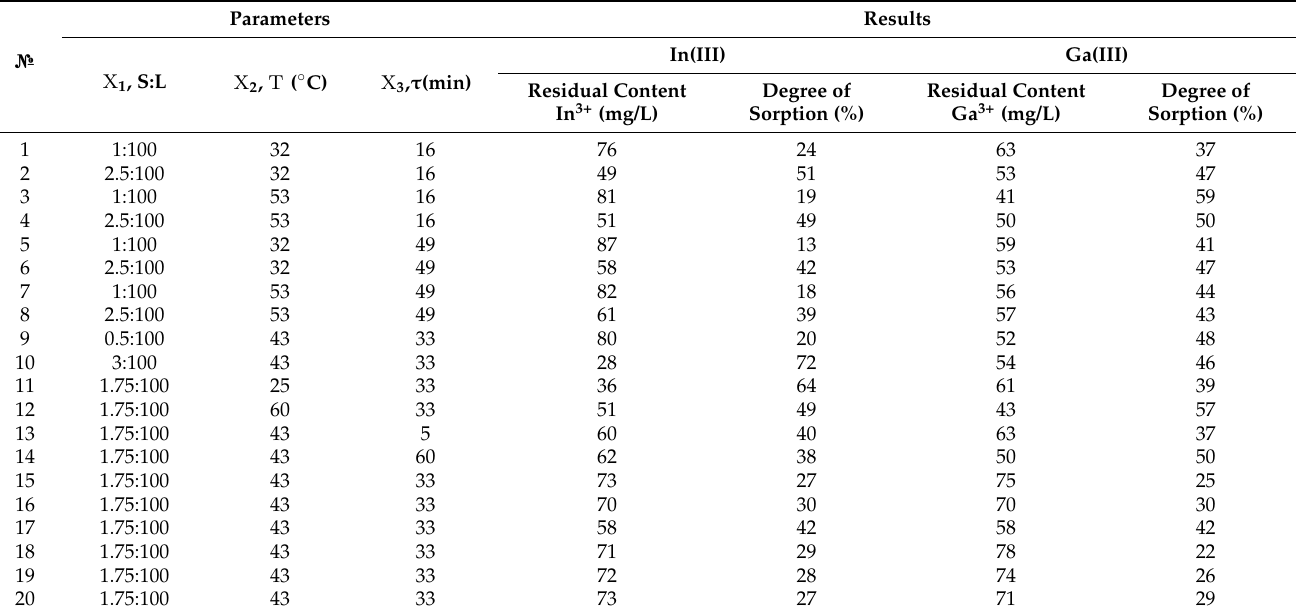
Table 3. Planning matrix and results of the experiment of the cation sorption in the “natural zeolite– In 3+ –Ga 3+ –H 2 O” system.